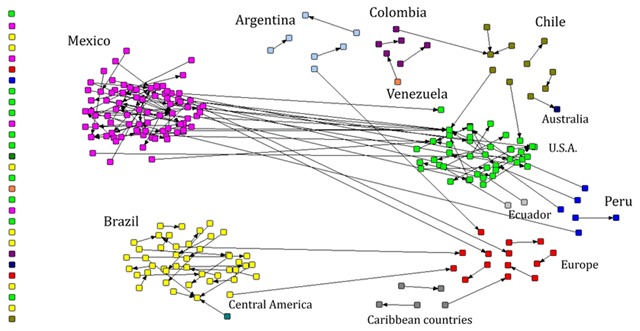
Network of authors and correspondents in 409 articles on children’s environmental health in Latin America, by country.Arrows start from the first to the corresponding author.